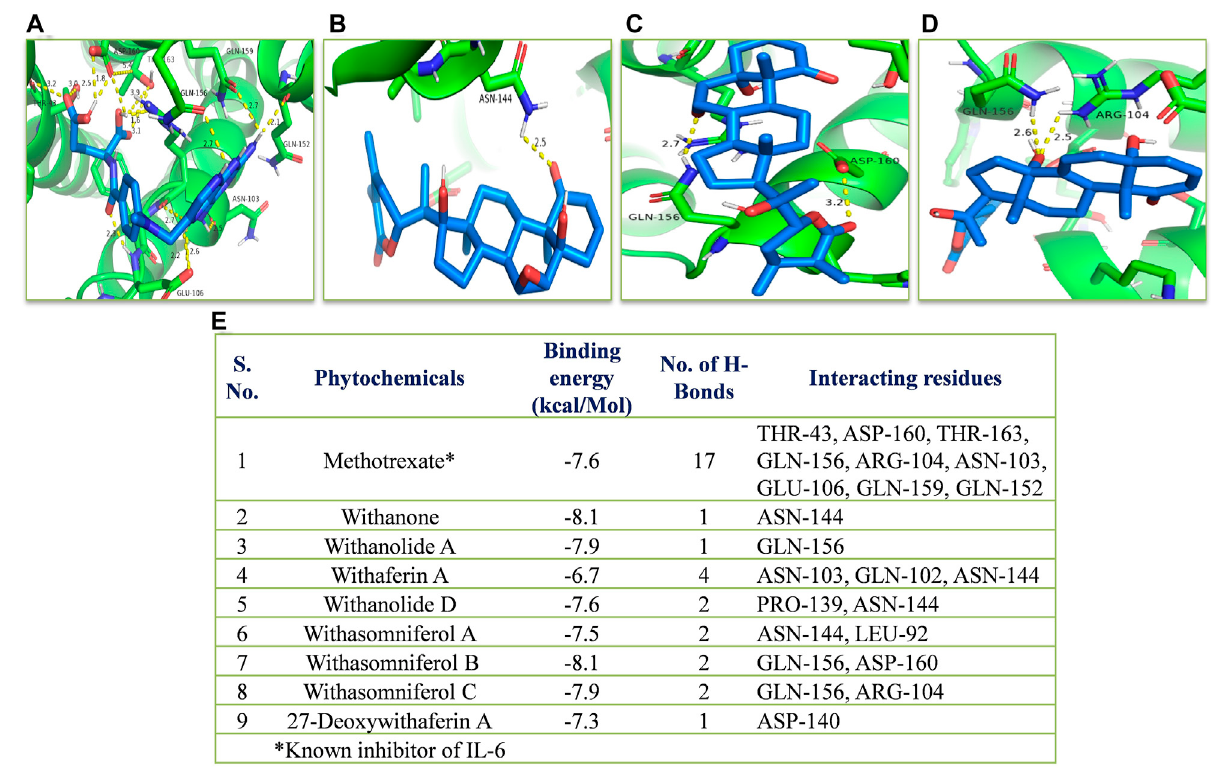
FIGURE 10 | Molecular docking of the proposed withanolides with IL-6. Docked conformations of withanolides and known inhibitor (A) methotrexate, (B) withanone, (C) withasomniferolB, (D) withasomniferol (C) withintheIL-6inhibitor-bindingcavity; (E) moleculardockingresultstable.Theproteininteractingresiduesare labeled (in black) with the H-bond interactions (represented by yellow dashed